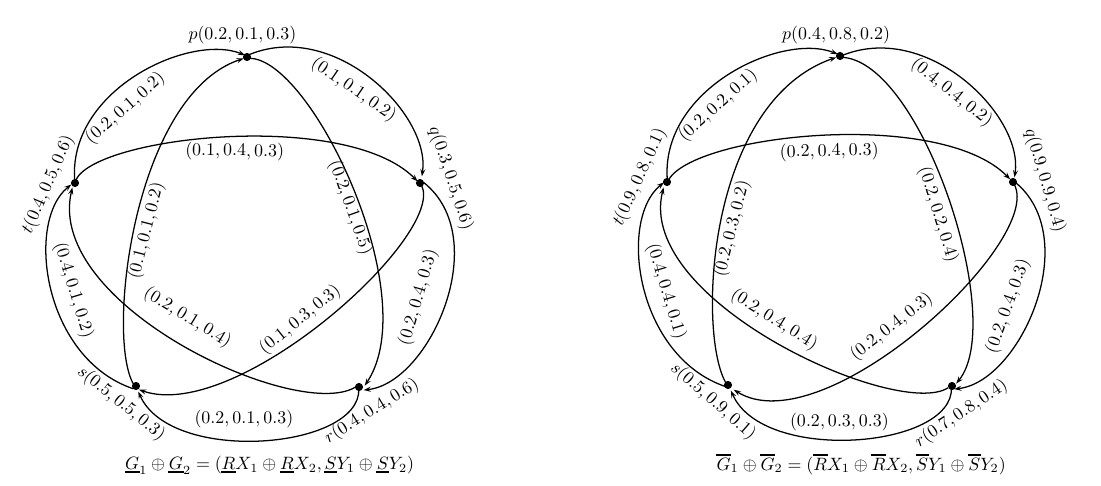
Figure 5: Neutrosophic Rough Digraph G = ( G Figure 5. Neutrosophic rough digraph G = ( G 1